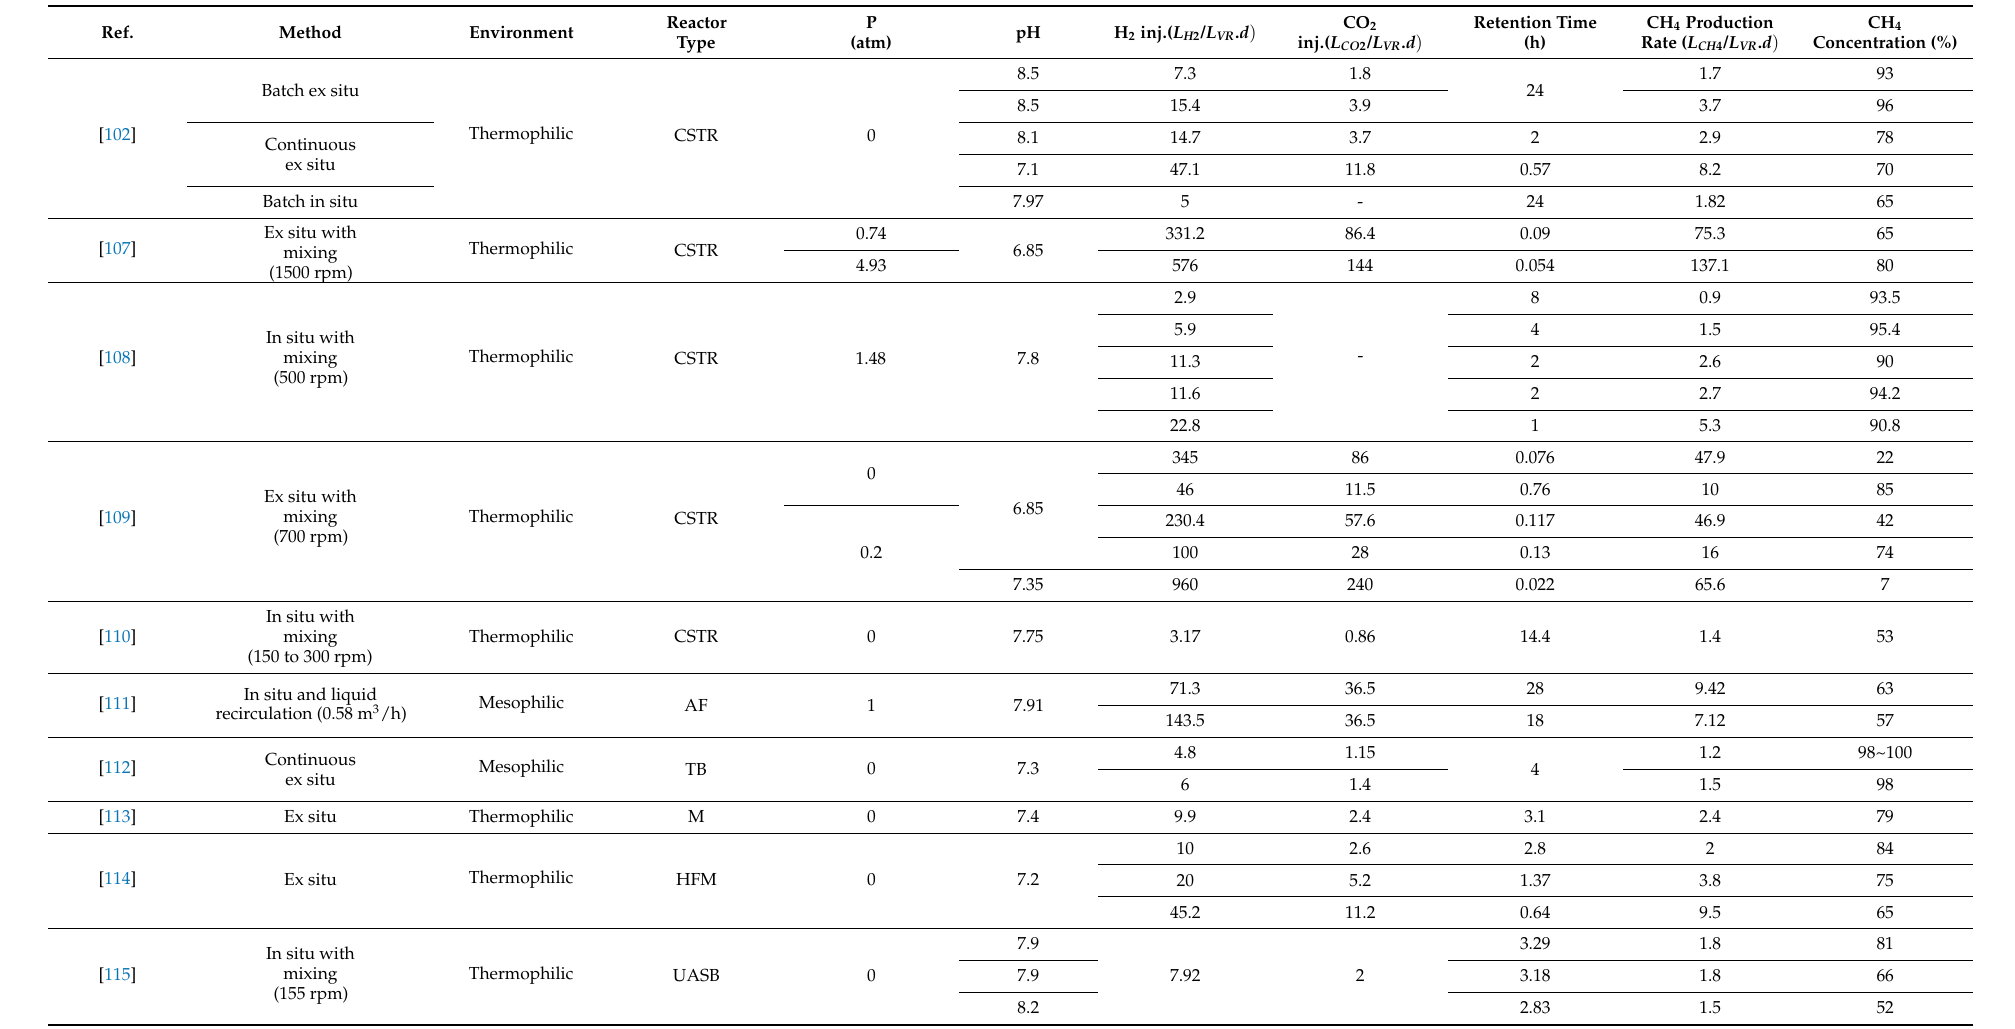
Table 4. Biological hydrogen methanation